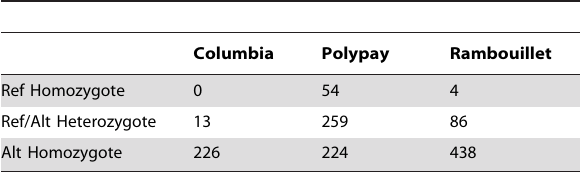
Table 2. Genotypic Frequency of Divergent Artiodactyl MYADM- like Repeat in Expanded Production Trait Population.